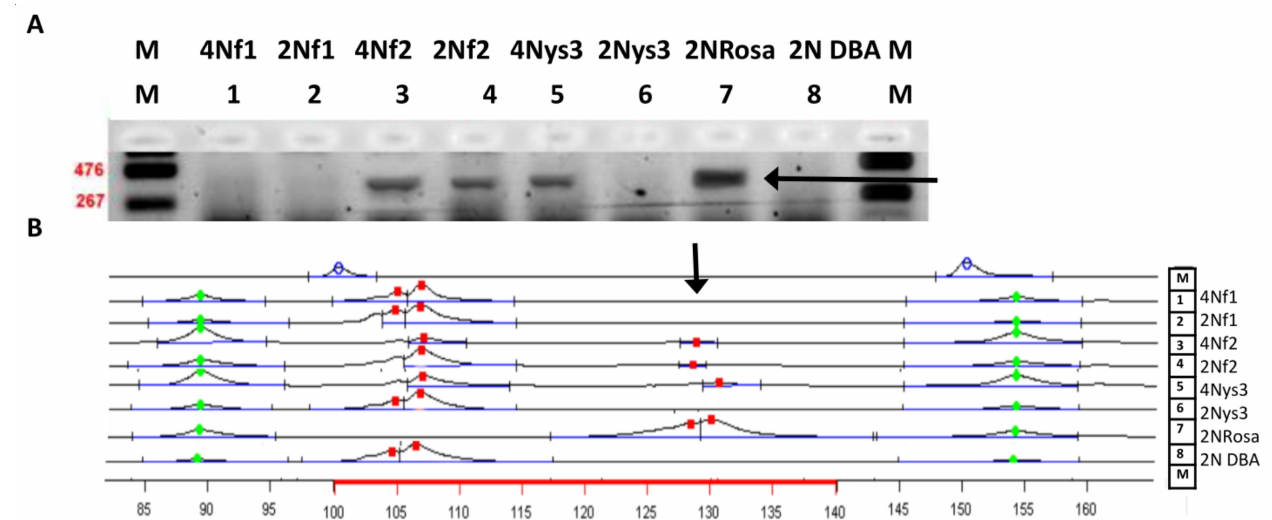
Figure 7. Donor markers in sorted fractions of diploid and tetraploid cells. ( A ) Photography of agarose gel after elec- trophoresis ( B ) microsatellite marker analysis. M: marker; 1: 4n cells from foetal tissues of foetus 1; 2: 2n cells from the same material; 3: 4n cells from foetal tissues of foetus 2 (both markers present); 4: 2n cells from the same material (both markers present); 5: 4n cells from yolk sac of foetus 3 (both markers present); 6: 2n cells from yolk sac of foetus 3; 7: 2n foetal tissues from ROSA donor (both markers present); 8: 2n foetal tissues from DBA/2 donor; M: marker. Arrows show donor marker occurrence. Red marks indicate the appropriate length of the microsatellite sequences identified in the cells; green marks indicate the appropriate size of the additional flanking length